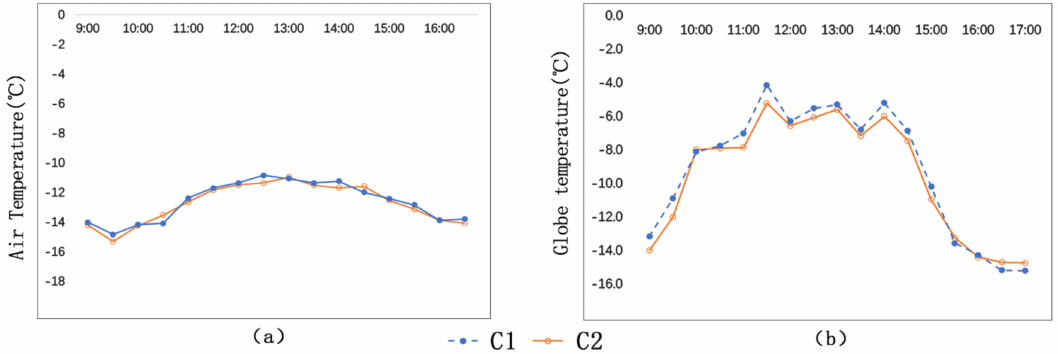
Figure 7. Comparison of air temperatures and globe temperatures of C1 and C2: ( a ) Ta; ( b )